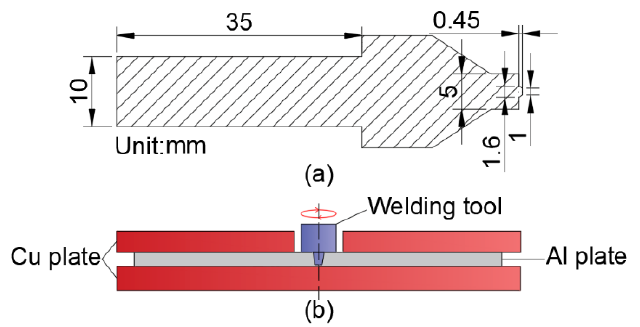
Figure 2. ( a ) Size of the microwelding tool, ( b ) Welding assembly diagram.